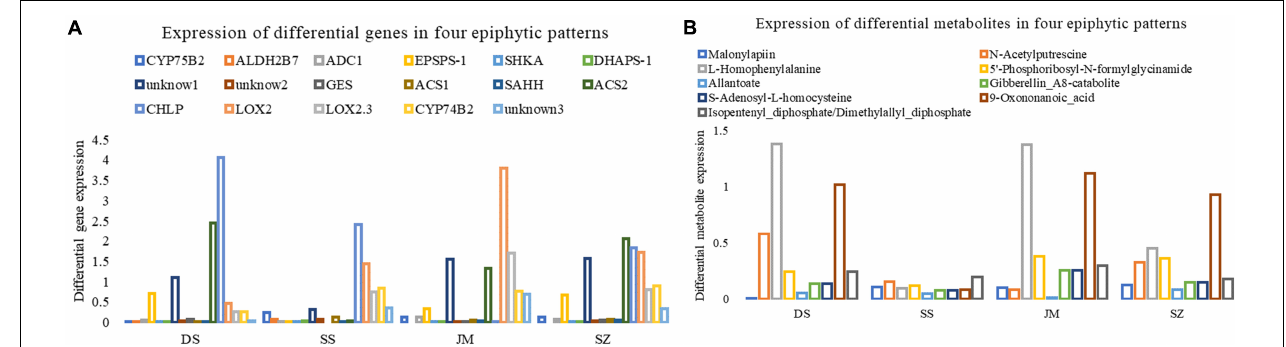
FIGURE 7 | Changes of differential genes and differential metabolites under different epiphytic patterns. The abscissa represents four different epiphytic patterns. Danxia stone (CSXTDS, DS), Crushed stone (CSXTSS, SS), Sawdust (CSXTJM, SS), and Stump (CSXTSZ, SZ). (A) Differential gene expression. Unknow1 is TRINITY_DN29493_c2_g1, unknow2 is TRINITY_DN36595_c0_g2 , unknow3 is TRINITY_DN31712_c4_g2. (B) Peak areas of differential metabolites under different epigenetic patterns.